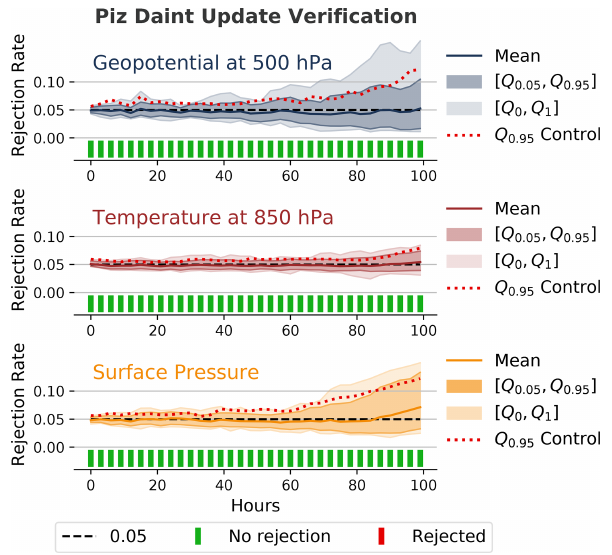
Figure 8. Rejection rates and decisions similar to Fig. 3 for the 500hPa geopotential, 850hPa temperature, and surface pressure from the verification of a major system update of the underlying supercomputer Piz Daint. The methodology cannot reject the null hypothesis (at least not for the used ensemble size of n E = 50, sub- sample size of n S = 20, and m = 100 subsamples), which suggests that the update did not significantly affect the model behavior. Figure 9. Rejection rates and decisions for the 500hPa geopoten-